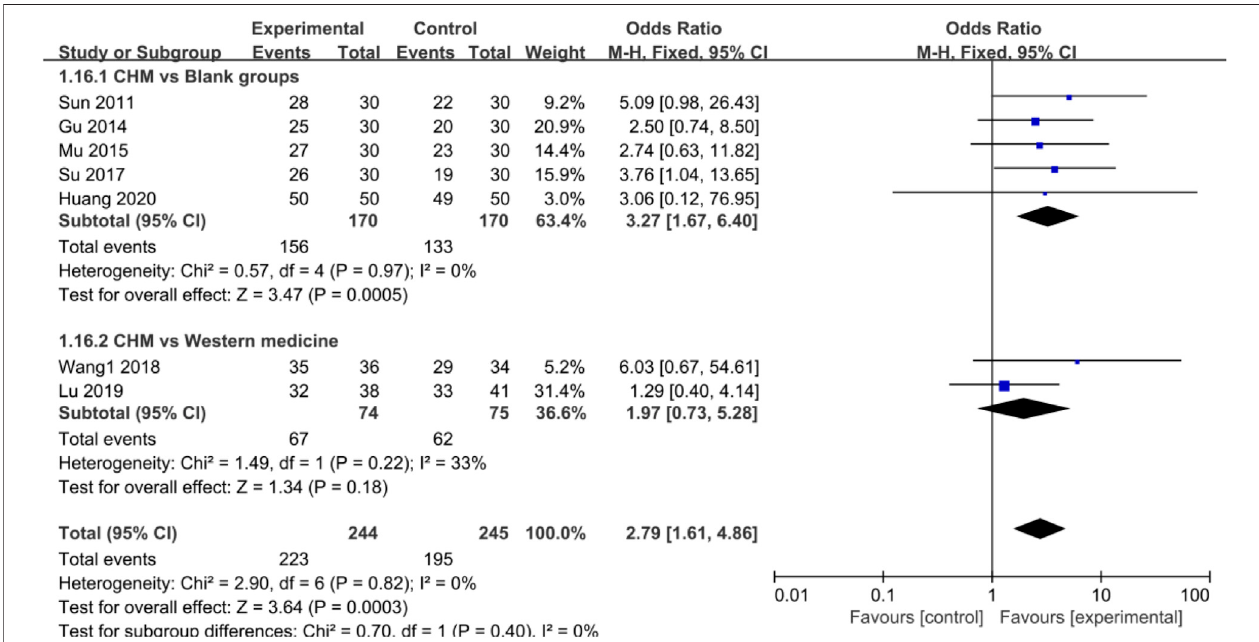
FIGURE 6 | Forest plot: CHM improved HAMD ef fi cacy in CHD with depression compared with control groups.